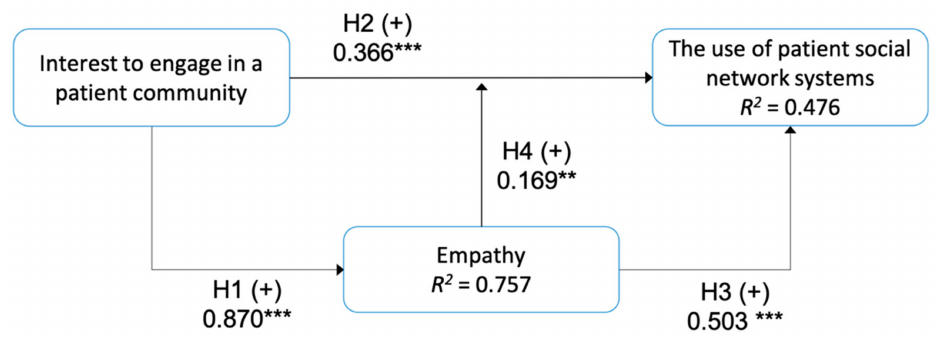
Figure 2. Results of the structural model (Note: ** p < 0.01, *** p <